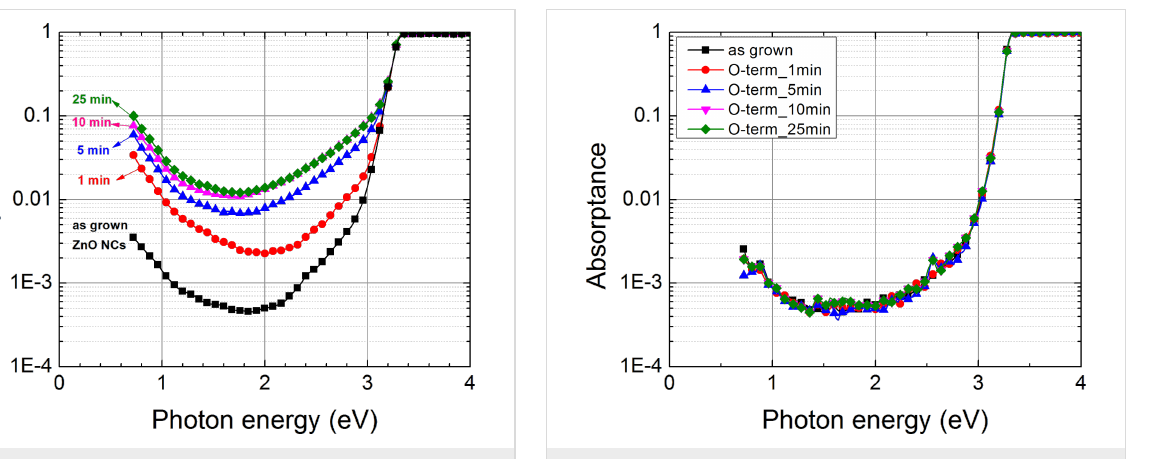
gies of 2 eV. The infrared optical absorption increases with hydrogen plasma treatment indicating the increase of the free- carrier concentration as described in the Drude model. The increase of the free-carrier concentration is reasonably ex- pected to increase the electrical conductivity of the ZnO NCs.